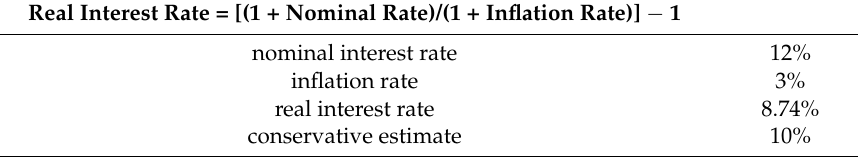
Table 21. Calculation of a conservative estimate for interest